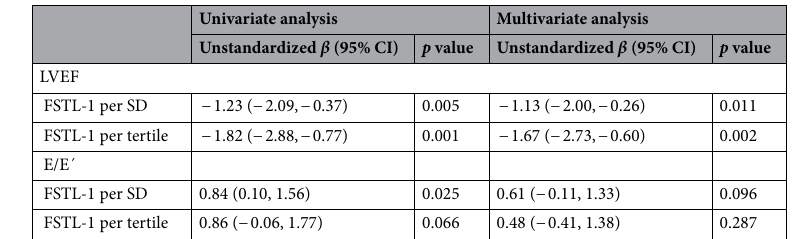
Table 3. Relationship between FSTL-1 and left ventricle systolic and diastolic functions. All analyses were adjusted for the following covariates: age, sex, BMI, history of CV events, diabetes, hsCRP level, and dialysis duration. FSTL-1 follistatin-like protein-1, BMI body mass index, CV cardiovascular, hsCRP high-sensitivity C-reactive protein, E/E´ early diastolic mitral inflow velocity/late diastolic mitral inflow velocity, LVEF left ventricular ejection fraction, SD standard